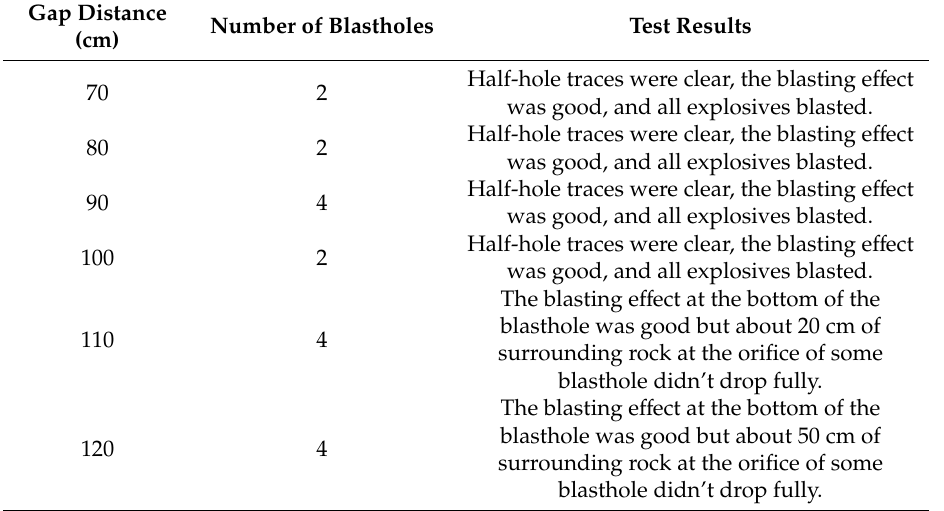
Table 2. Test results for sympathetic detonation in blastholes.